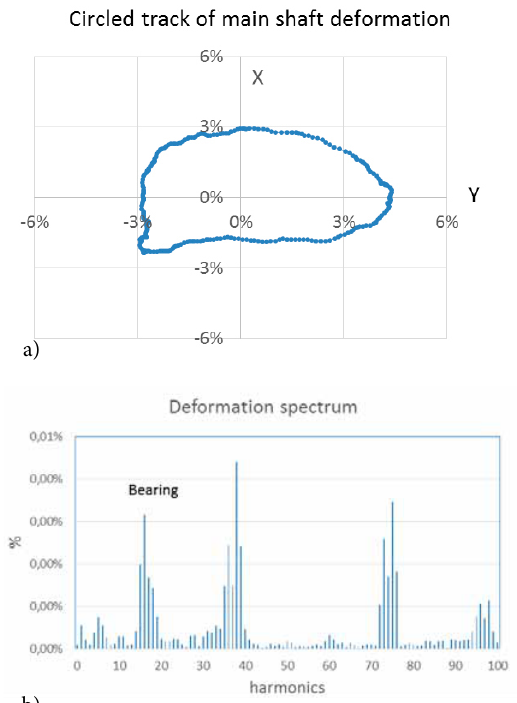
Fig. 10. Data extracted from the shaft deformation